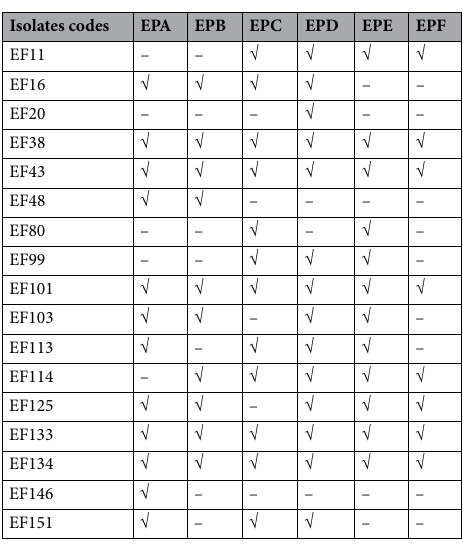
Table 1. Lytic activity spectra of 6 different enterococcal phages (EPA: F) against different enterococcal isolates (n = 17). Isolate codes (EF)*: are the codes for E. faecalis isolates. (√) indicates bacterial lysis, (–) indicates absence of plaques (no